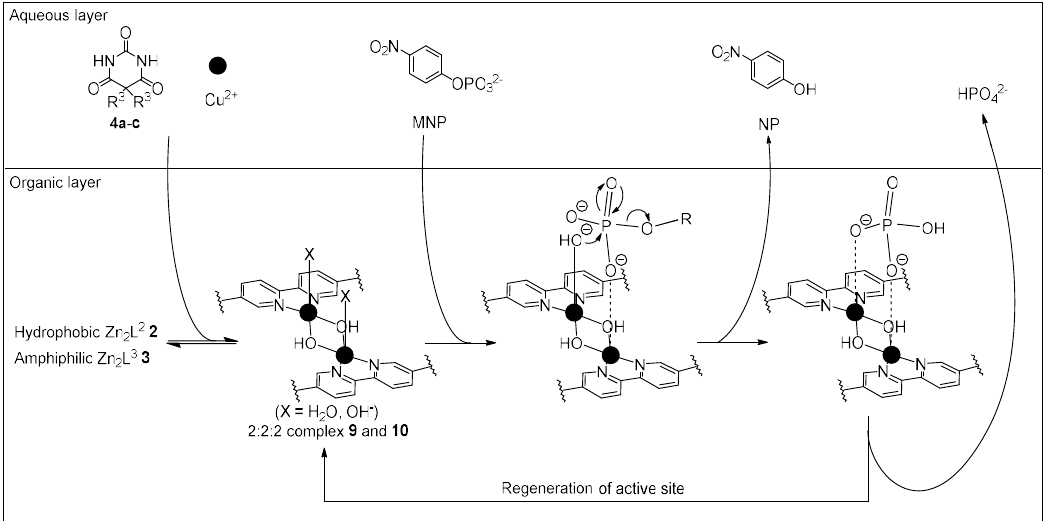
Scheme 2. Concept of the hydrophobic supramolecular complexes 9 and 10 and the hydrolysis of mono(4-nitrophenyl) phosphate (MNP) in a two-phase solvent system, in which the